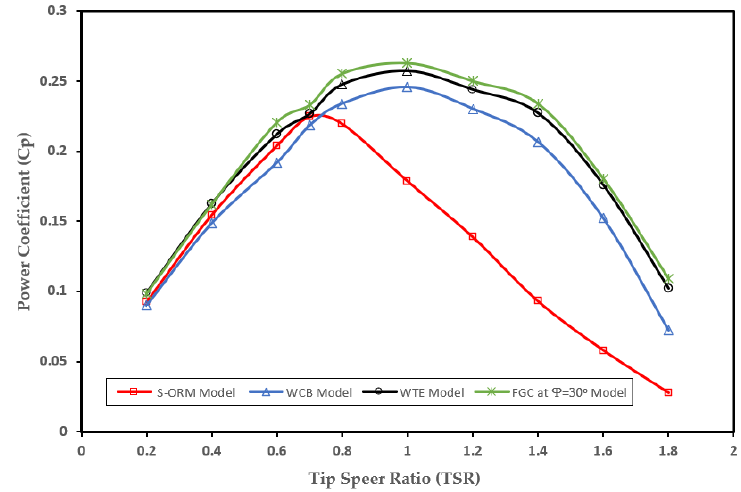
Figure 16. Results of the simulation of the variations in the power coefficients of modified models, along with the S-ORM.